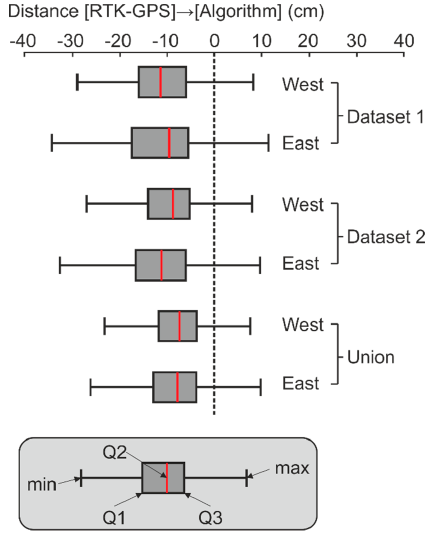
Figure 12. Boxplot of distance ((RTK-GNSS) → (Algorithm)) quantile distribution. Q1, Q2, and Q3 represent the quartiles, and min and max refer to 1.5 times the IQR (interquartile range) from the upper and lower quartiles respectively.